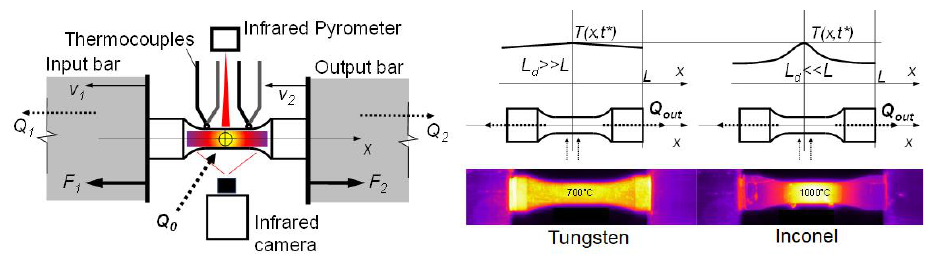
Fig. 2. Scheme of the temperature control systems adopted in dynamic high temperature tests (left); comparison between heating obtained on pure tungsten and Inconel 718 cylindrical dog-bone specimens with the same dimension by imposing the same heating